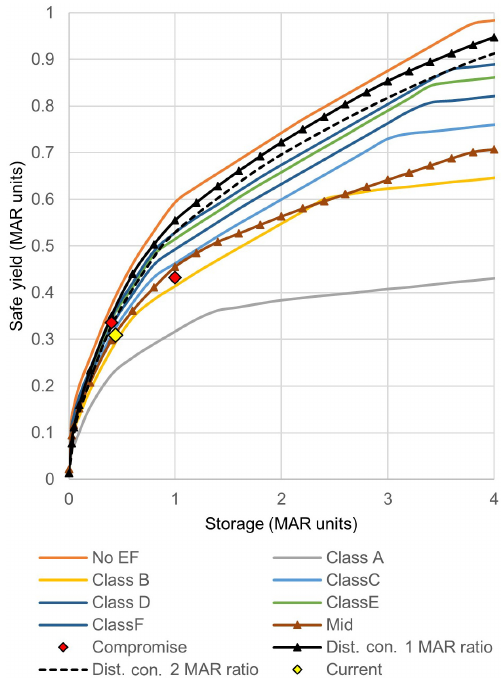
Figure 2. Behaviour of Safe Yield for a centralized hypothetical reservoir under different EF releases, compared with those for two distributed reservoir configurations under which no explicit EF re- leases are